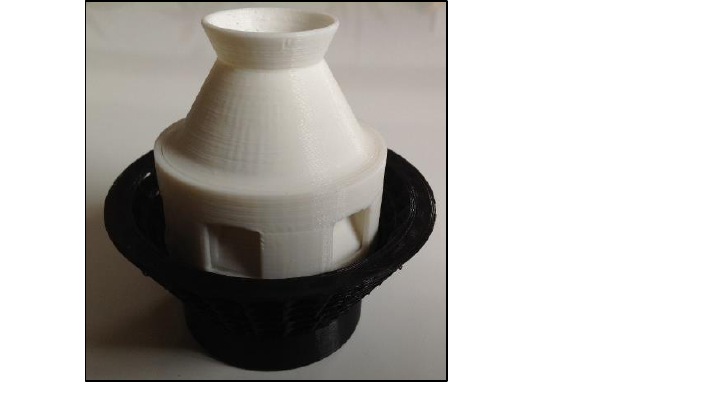
Figure 13. An impeller, nozzle, and control sleeve (diaphragm) prototype together with a conical centrifugal turbine